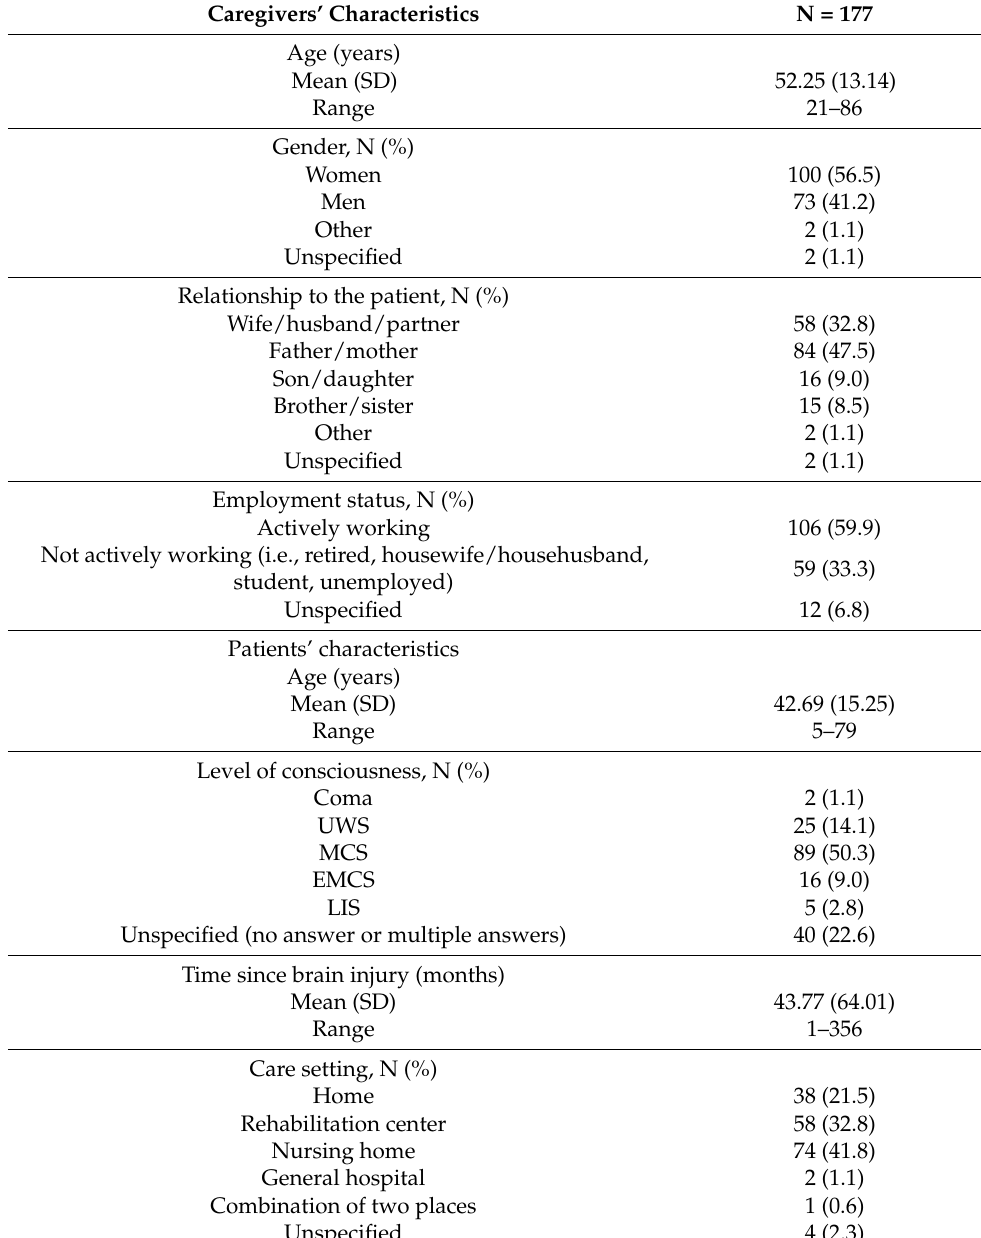
Table 2. Baseline socio-demographic characteristics of the